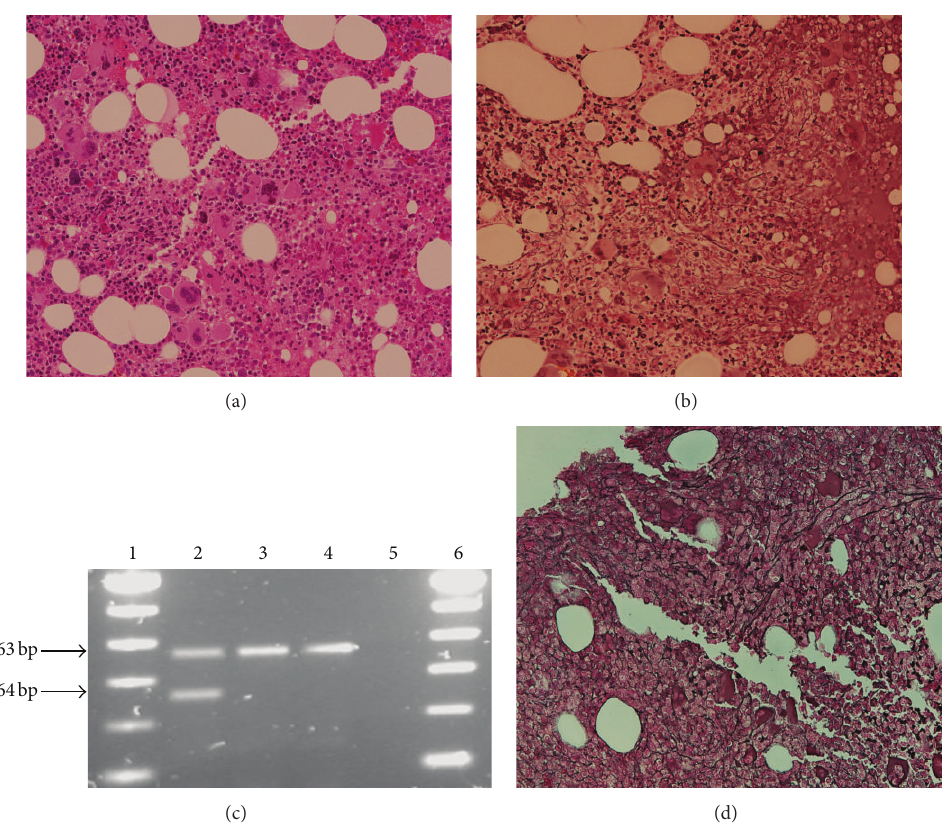
Figure 1: (a) Clustering of numerous pleomorphic megakaryocytes; (b) low grade bone marrow reticulin fibrosis; (c) allele-specific PCR for MPL S505N demonstrating wild type band (363 bp) and S505N specific band (264bp); lanes 1 & 6, 100bp ladder; lane 2, peripheral blood; lane 3, buccal scrape; lane 4, isolated T-cells; lane 5, water control; (d) significant increase in bone marrow reticulin fibrosis two years after